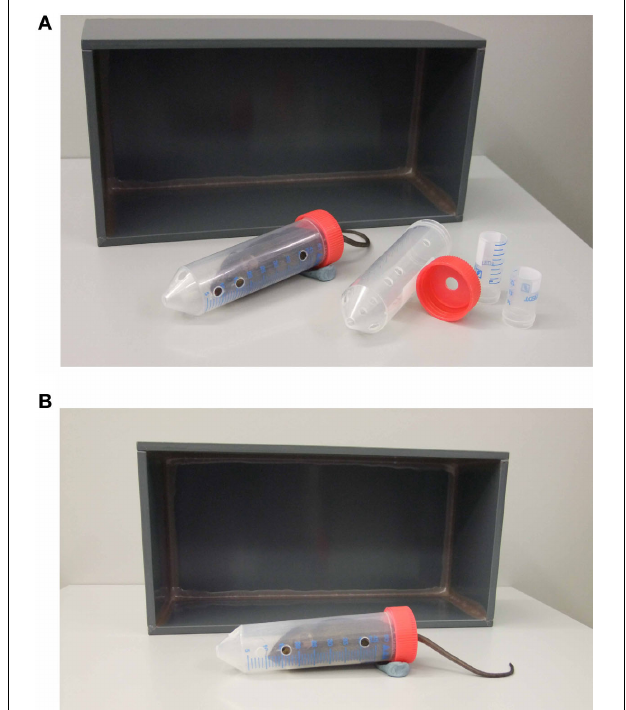
FIGURE 1 | Acute restraint stress equipment and set up. The necessary equipment used for the restraint stress is depicted in (A) . It consists of a 50ml restraint tube and cap with holes for breathing and the tail respectively, middle tubes of 4 and 3cm length and a box. The position of the animal inside the restraint tube under the box is depicted in (B) . Modeling clay is used to prevent the tube from rolling.